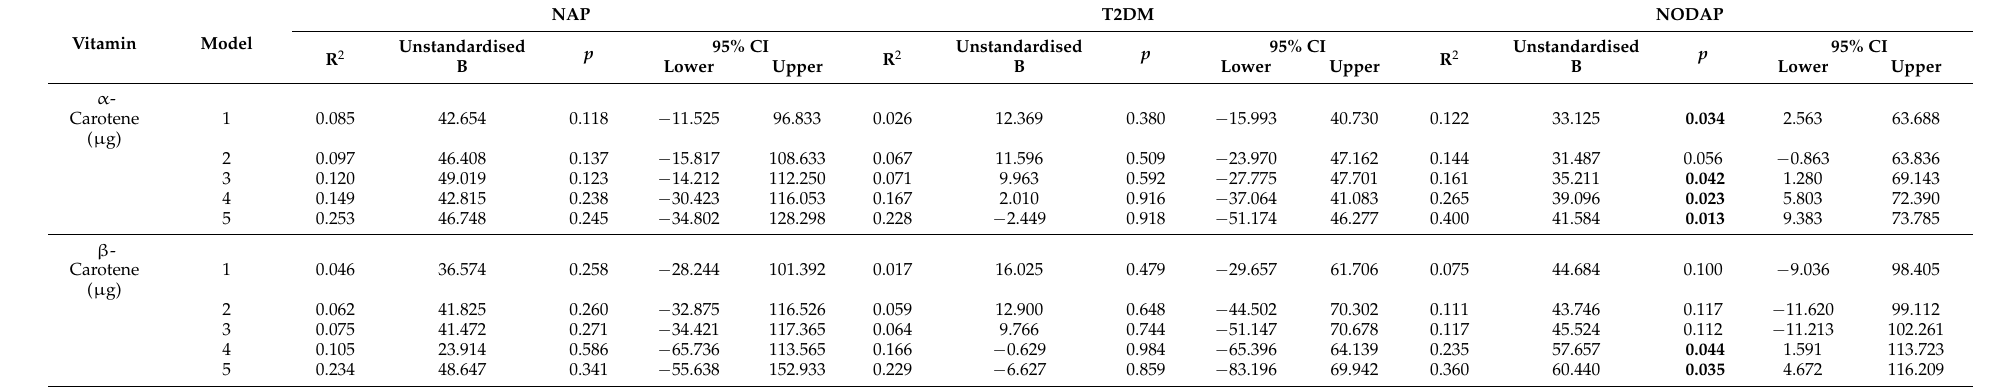
Table 3. Associations between habitual fat-soluble vitamin/vitamer intake and HOMA- β in the study